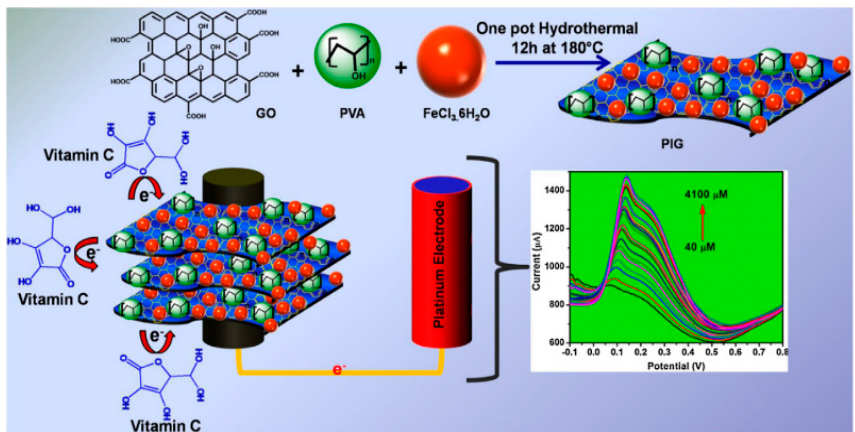
Figure 15. Schematic representation of synthesis and detection of vitamin C using graphene-iron oxide-polyvinyl alcohol (PIG). Reprinted with permission from reference [47]. Copyright © 2018 Elsevier B.V.